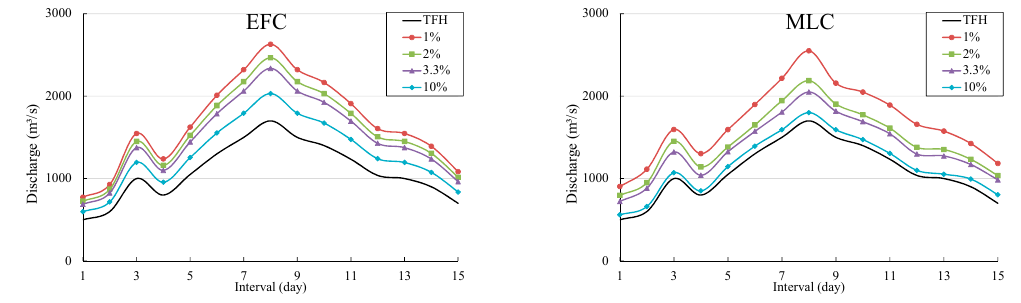
Figure 7. DFH derived by EFC method and MLC method at Jhelum river. Table 5. Comparison of flood quantiles estimated by different methods.